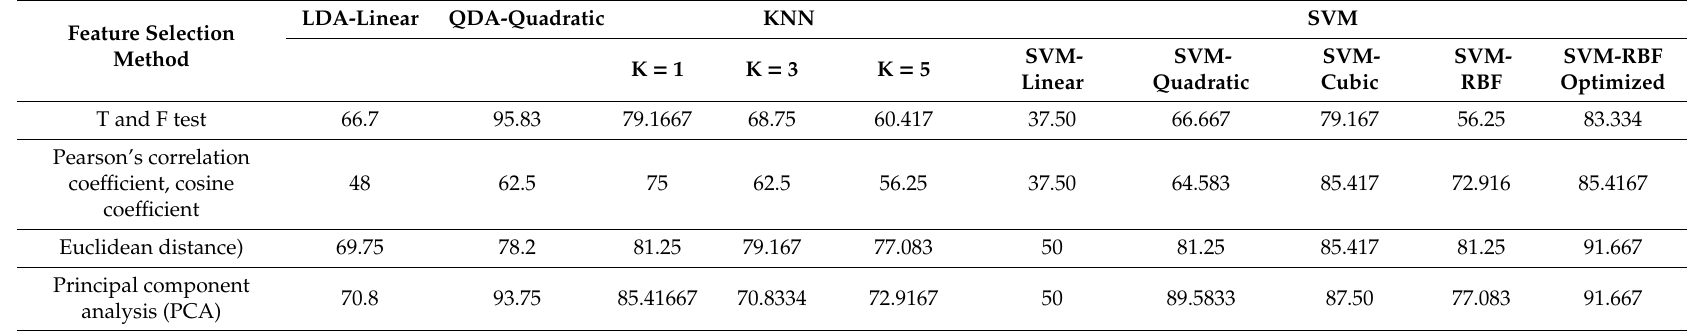
Table 6. The classification accuracies based on the generated samples of the extracted key